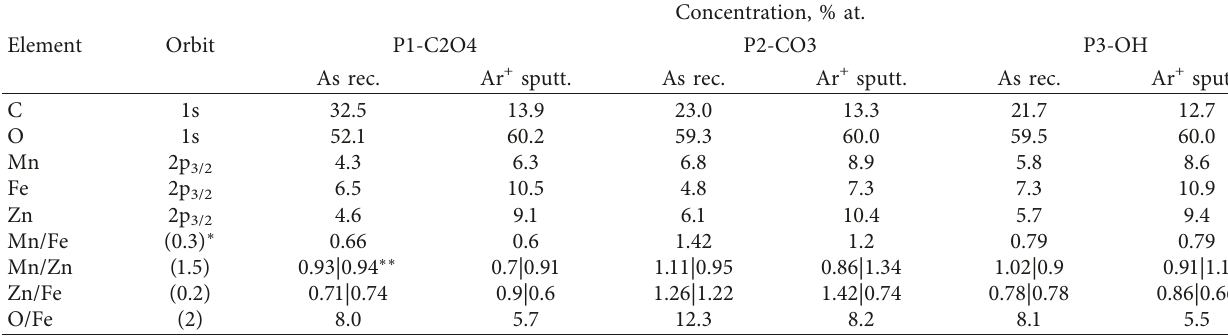
Table 3: XPS surface composition of Mn-Zn ferrites.